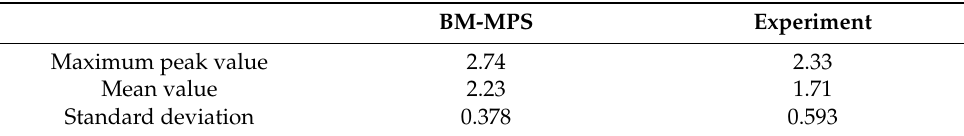
Figure 6. Time histories of impact pressure at point A without a baffle ( T = 1.91 s, ω / ω 0 = 1.004). Table 1. Statistics on the dimensionless maximum pressure.